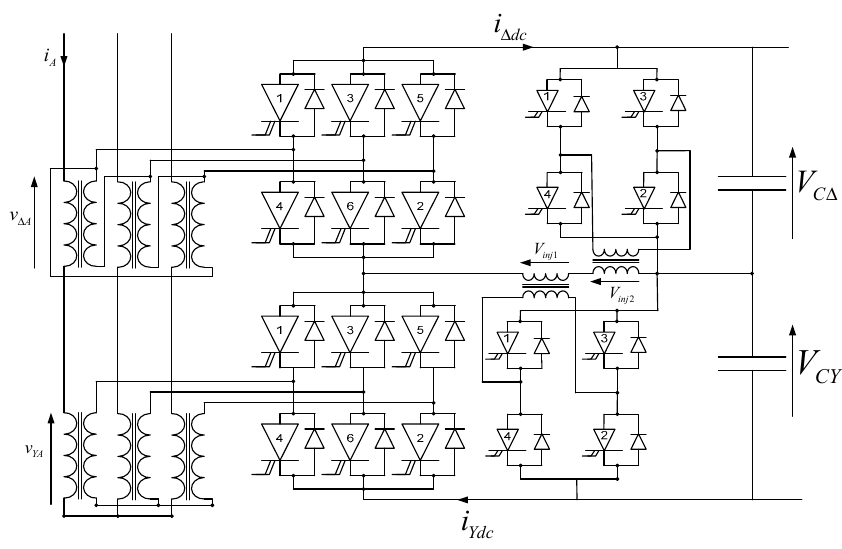
Figure 32. Reinjection Scheme.